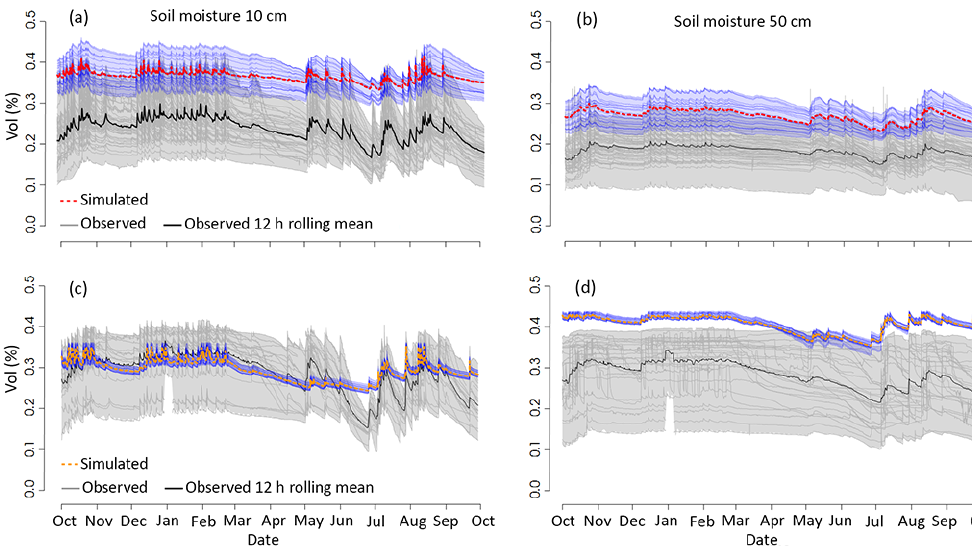
Figure 11. Observed soil moisture at 10 and 50cm depths in the schist (a, b) and marl (c, d) areas of the Attert catchment. Additionally the 12h rolling median (black) derived from the soil moisture observations and the simulated soil moisture dynamics at the respective depths (red Colpach; orange Wollefsbach) are